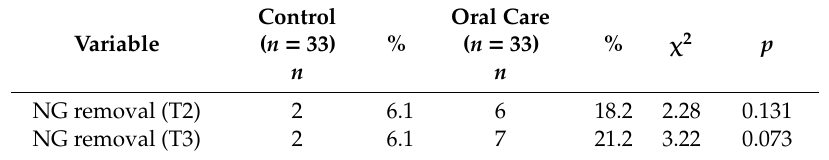
Table 4. Analysis of the e ff ects of the oral health programme on nasogastric tube removal ( n = 66).